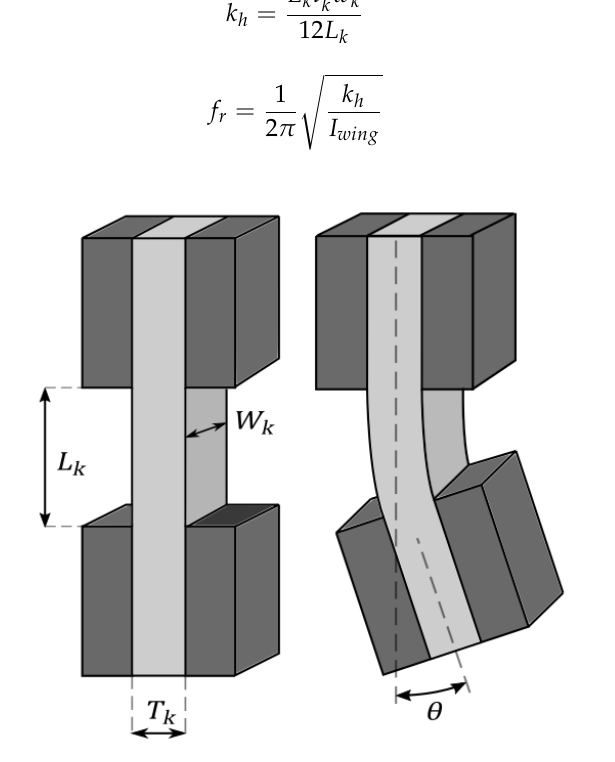
Figure 2. A compliant hinge mechanism with rigid outer layers and a compliant central